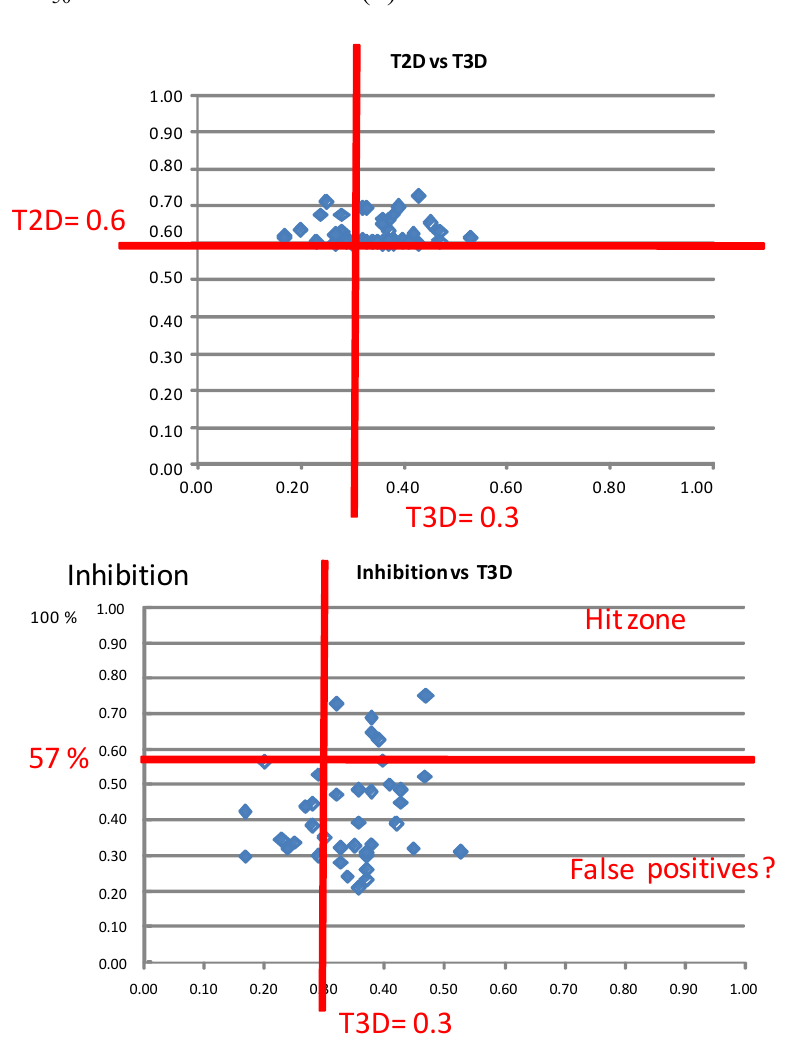
Figure 1. Scatter plot of all the measured compounds (41, active and not active) derived from the 3 seeds (#13, #18, #44) correlating the T2D and T3D similarity scores ( a ); and correlating the IC values and T3D values ( b 50